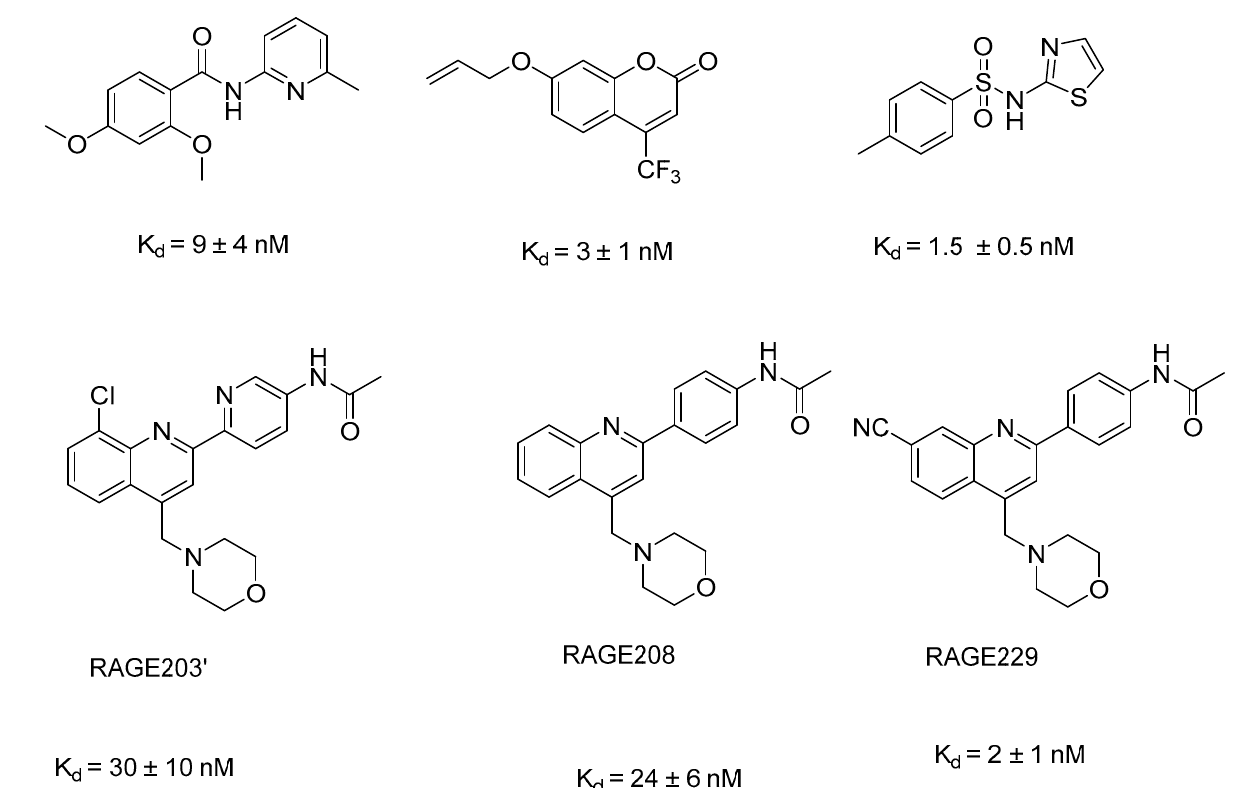
Figure 7. Structures of some of the lead compounds as RAGE-DIAPH1 antagonists, targeting ct-RAGE; these compounds block the extracellular AGE/RAGE mediated signaling transduction, and thereby prevent the formation of the AGE–RAGE mediated in fl ammatory cytokines.